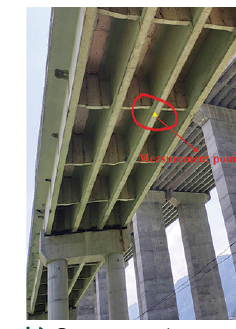
b) Cross-section a) Test bridge and